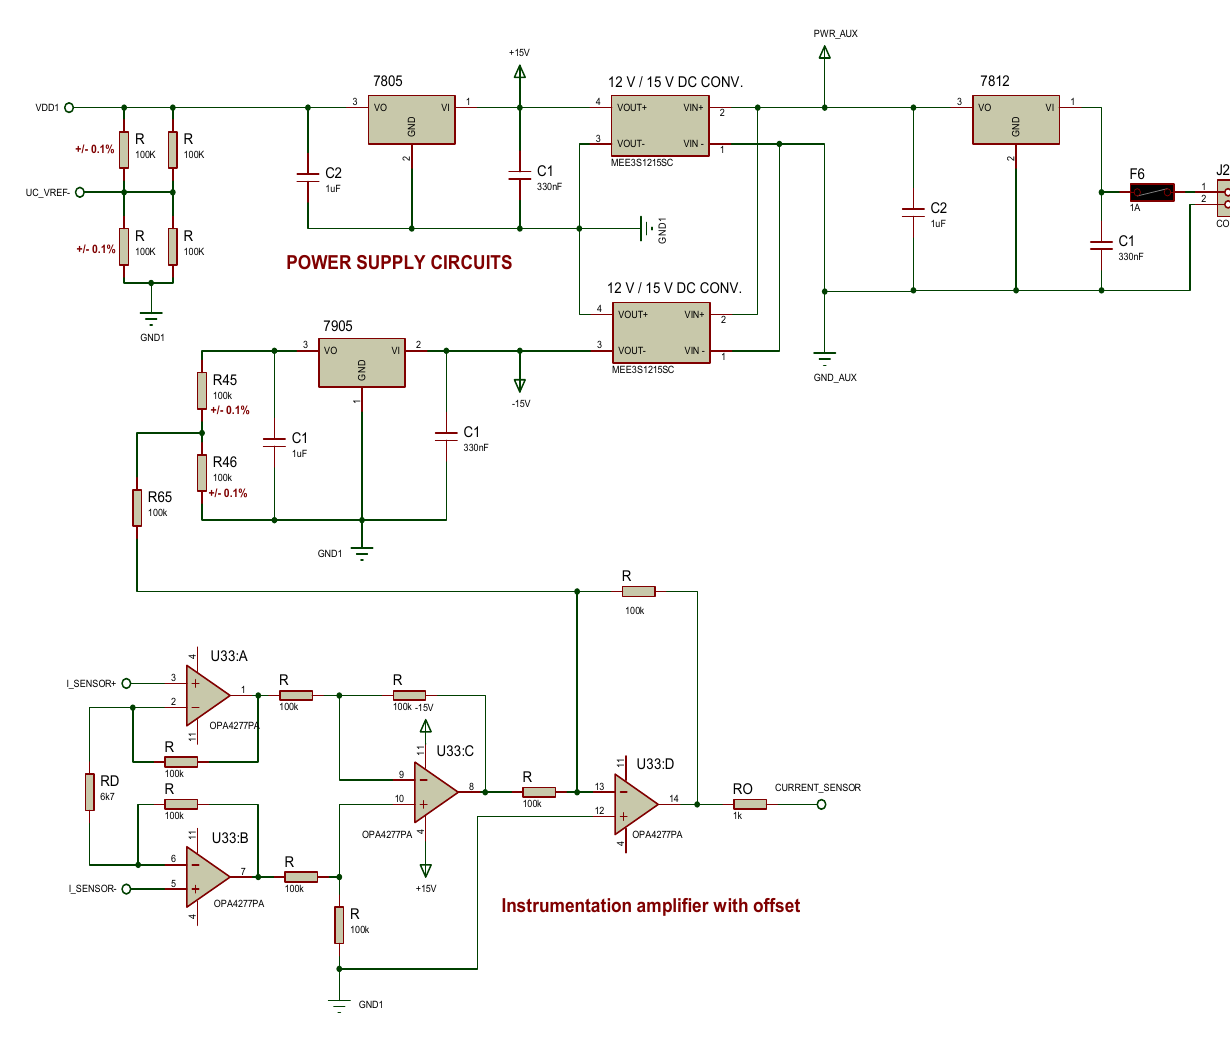
Figure 18. SSC Slave control circuit ISIS model Part 3: circuit power supply, and current sensing.